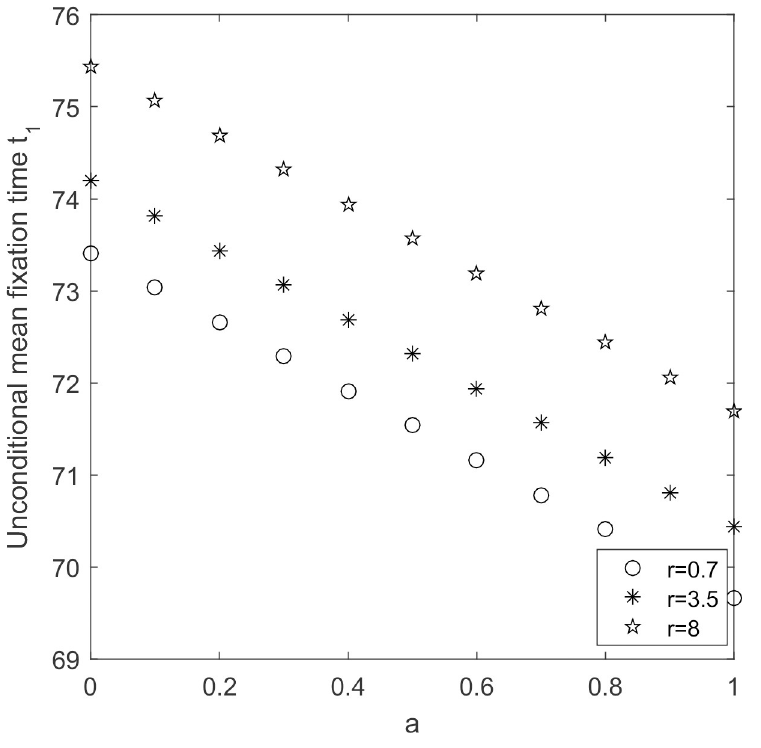
Fig 11. t 1 ~ r change